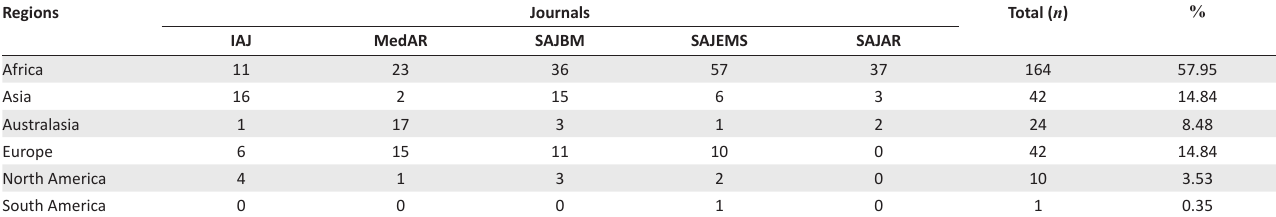
TABLE 10: Geographical regions of published authors.